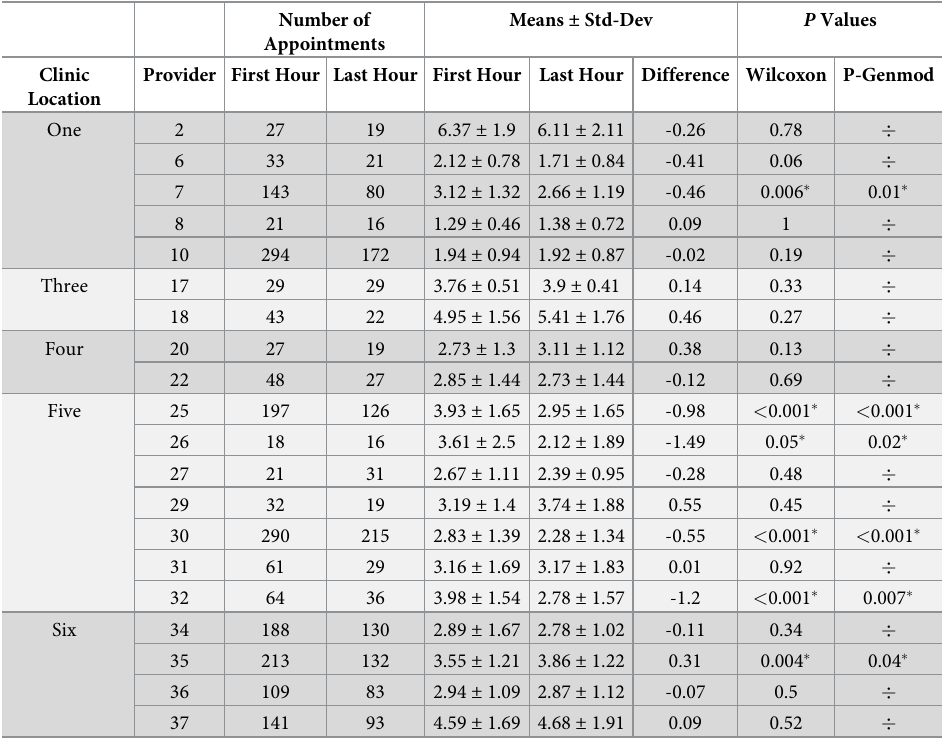
Table 3. Differences in mean number of diagnoses assessed.